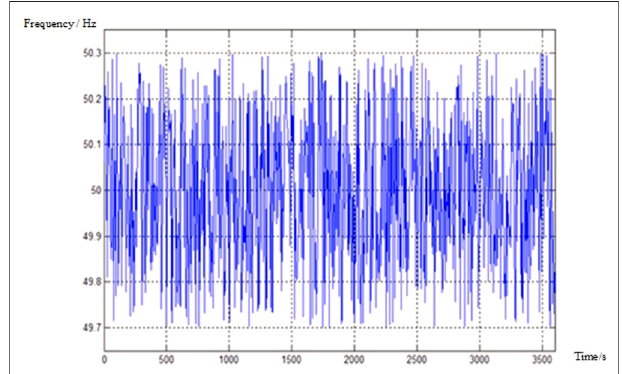
FIGURE 4 | The system frequency variation curve.